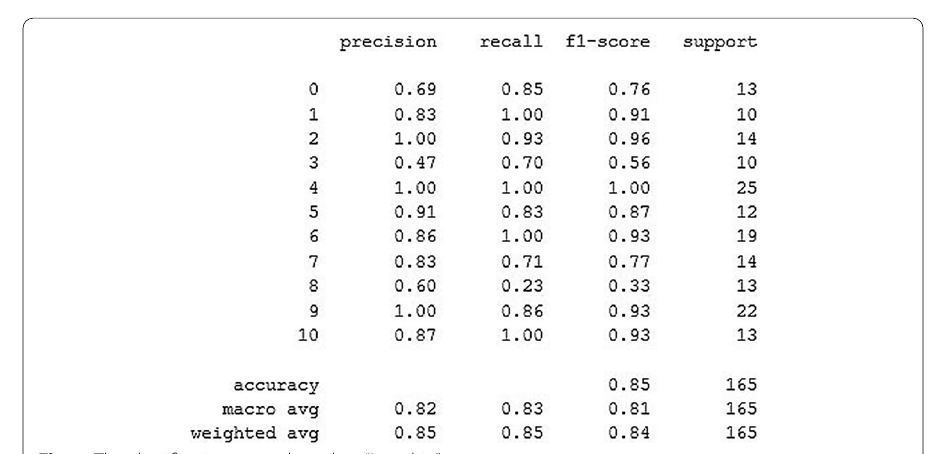
Fig. 4 The classification report based on